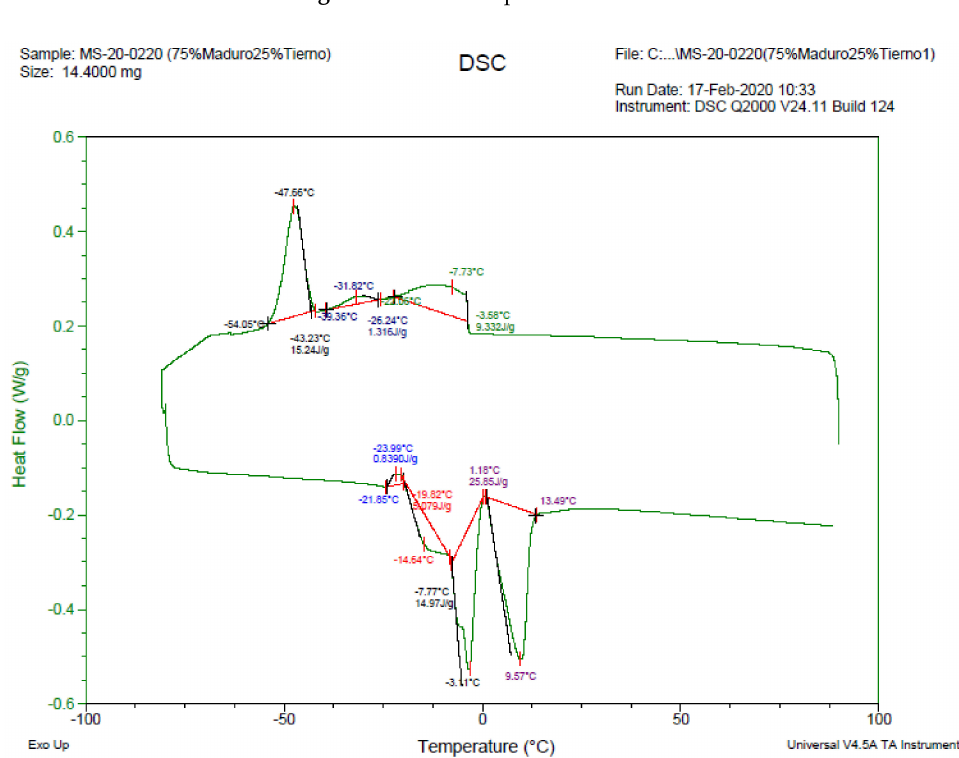
Figure A8. DSC Sample AA-50T-50M.